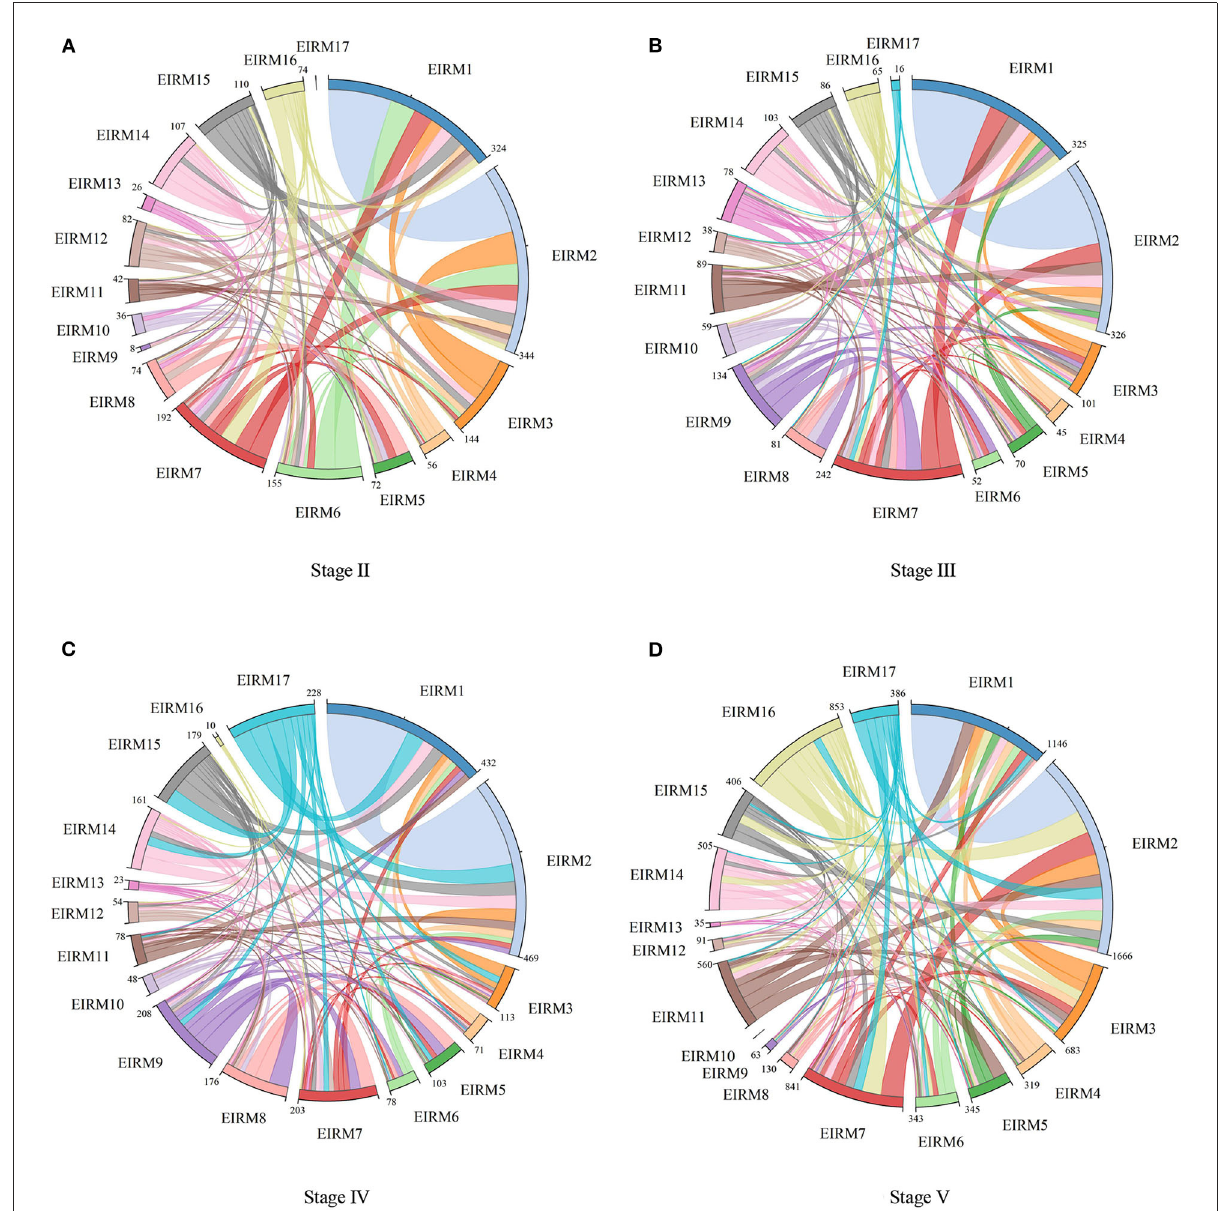
FIGURE4 The chord diagrams of resources sharing relationship EIRMs in Stage II-V. (A) Stage II, (B) Stage III, (C) Stage IV, and (D) Stage